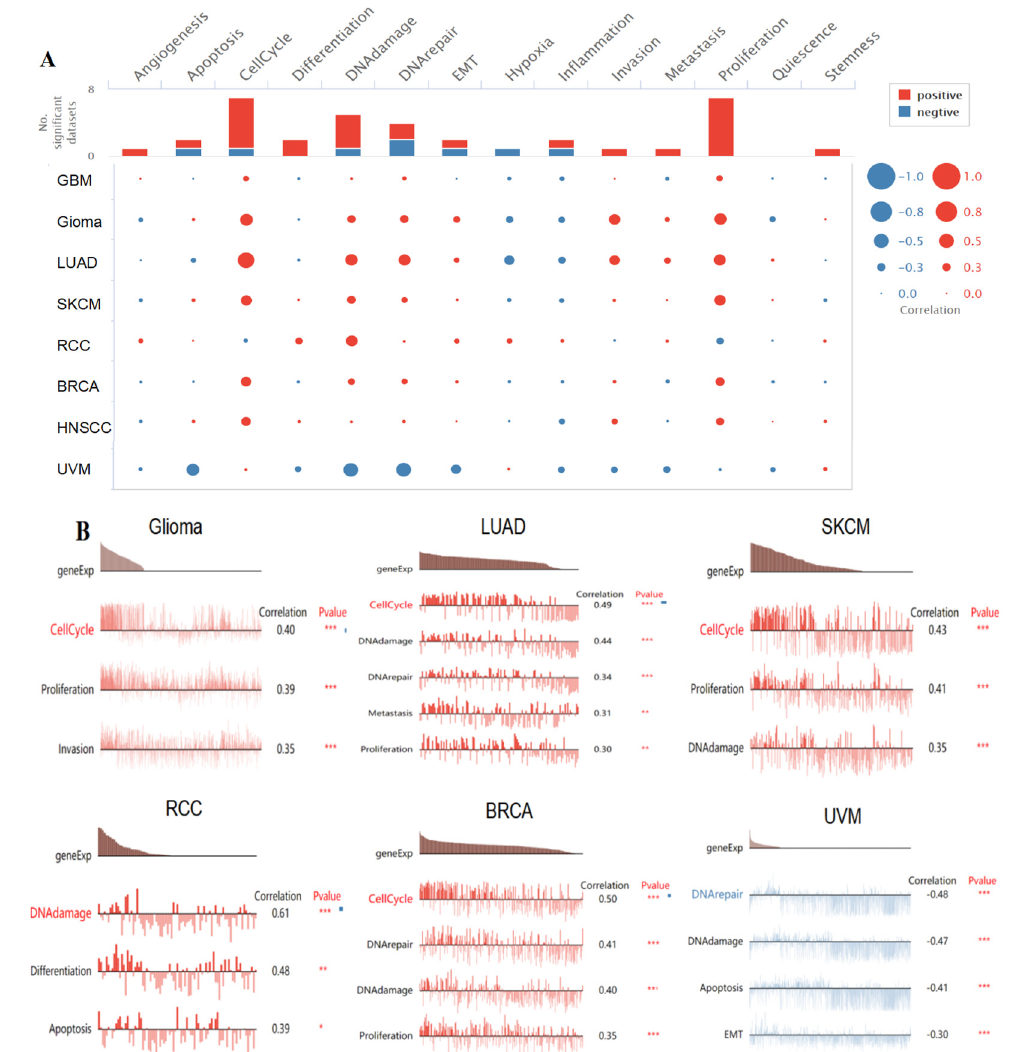
Figure 9. The function of KIF18A in single-cell functional analysis from the CancerSEA database. ( A ) Functional status of KIF18A in different human cancers. ( B ) Correlation analysis between functional status and KIF18A in glioma, LUAD, SKCM, RCC, BRCA, and UVM. (* p < 0.05, ** p < 0.01, *** p < 0.001).